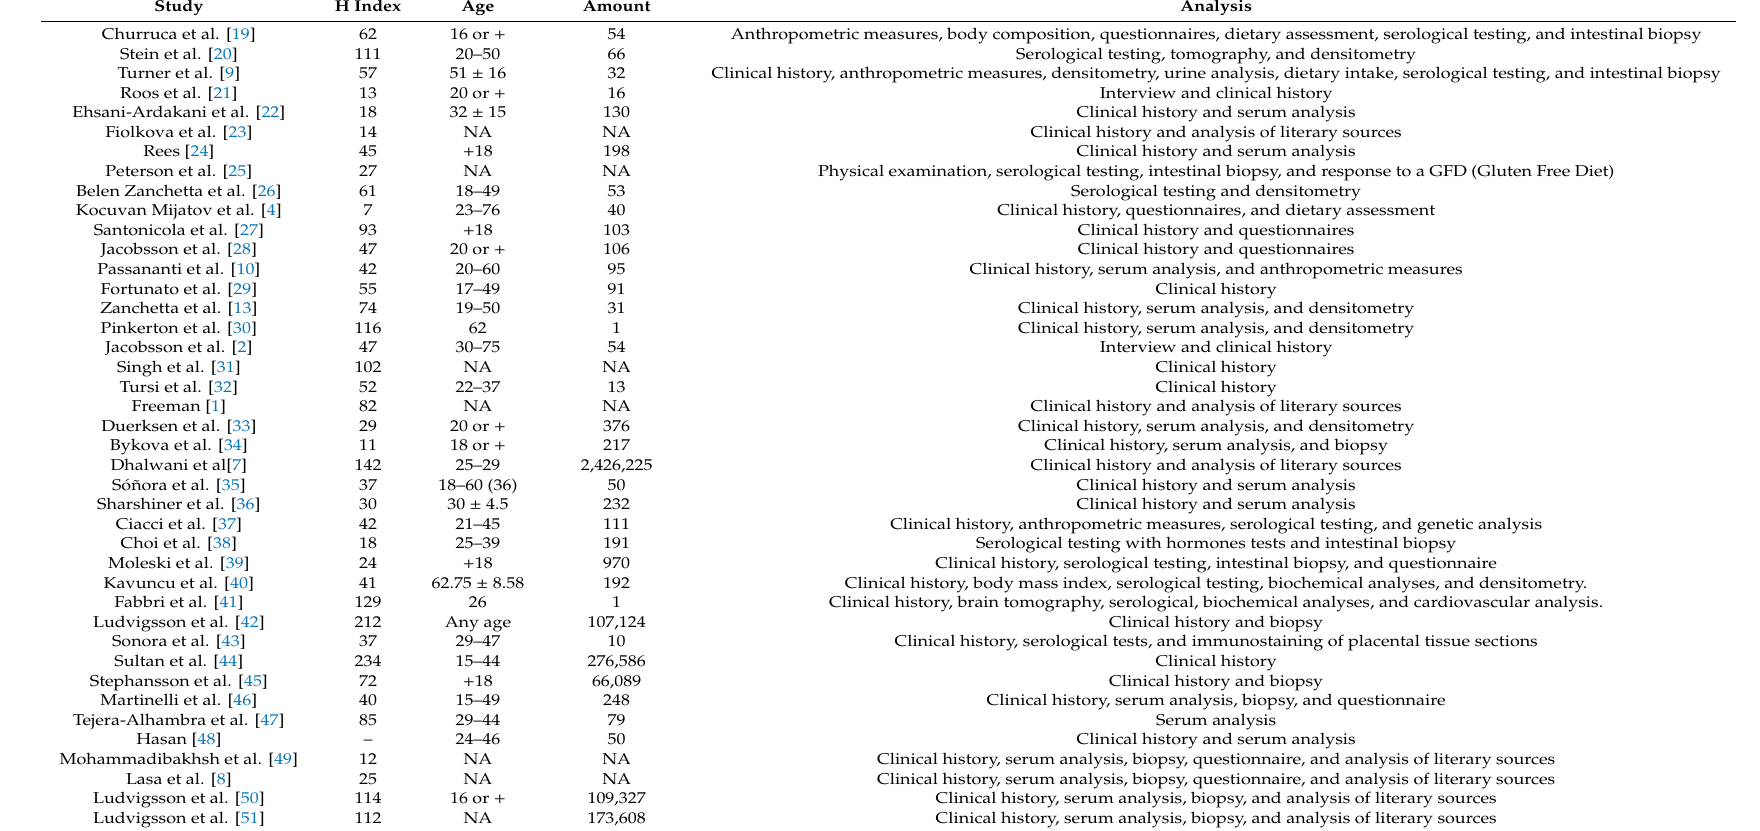
Table 1. Characterization of the